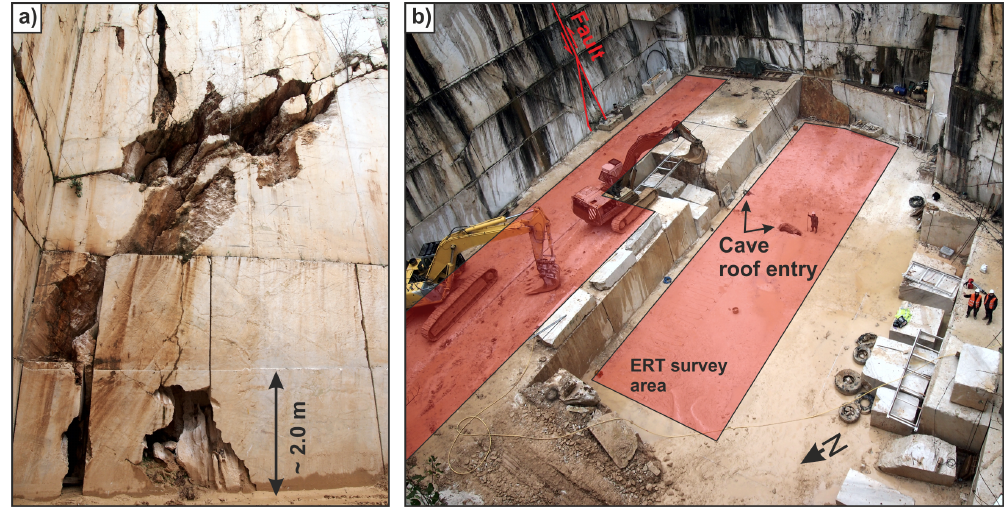
Figure 1. Geological map of Italy’s Lombardy region. The study site is located within Jurassic deposits, comprised mainly of dolomites. Geological data published by Regione Lombardia through CC-BY-NC-SA 3.0 Italia.